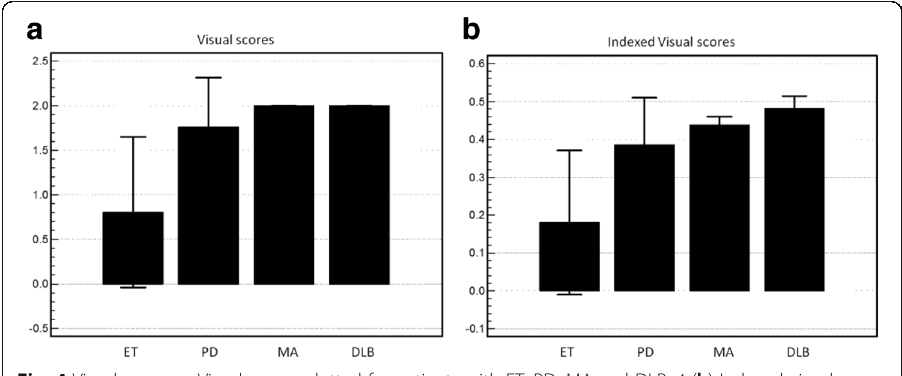
Fig. 4 Visual scores. a Visual scores plotted for patients with ET, PD, MA and DLB. 4 ( b ) Indexed visual scores plotted for patients with ET, PD, MA and